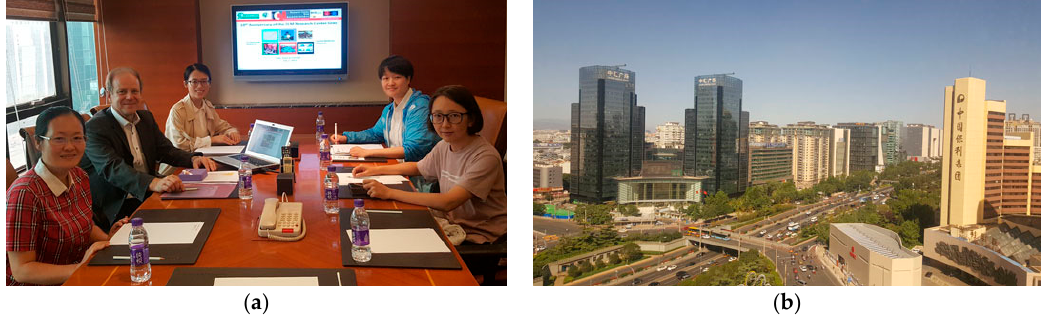
Figure 21. ( a ) From left to right: Associate Professor He Wei, Professor Gerhard Litscher, Assistant